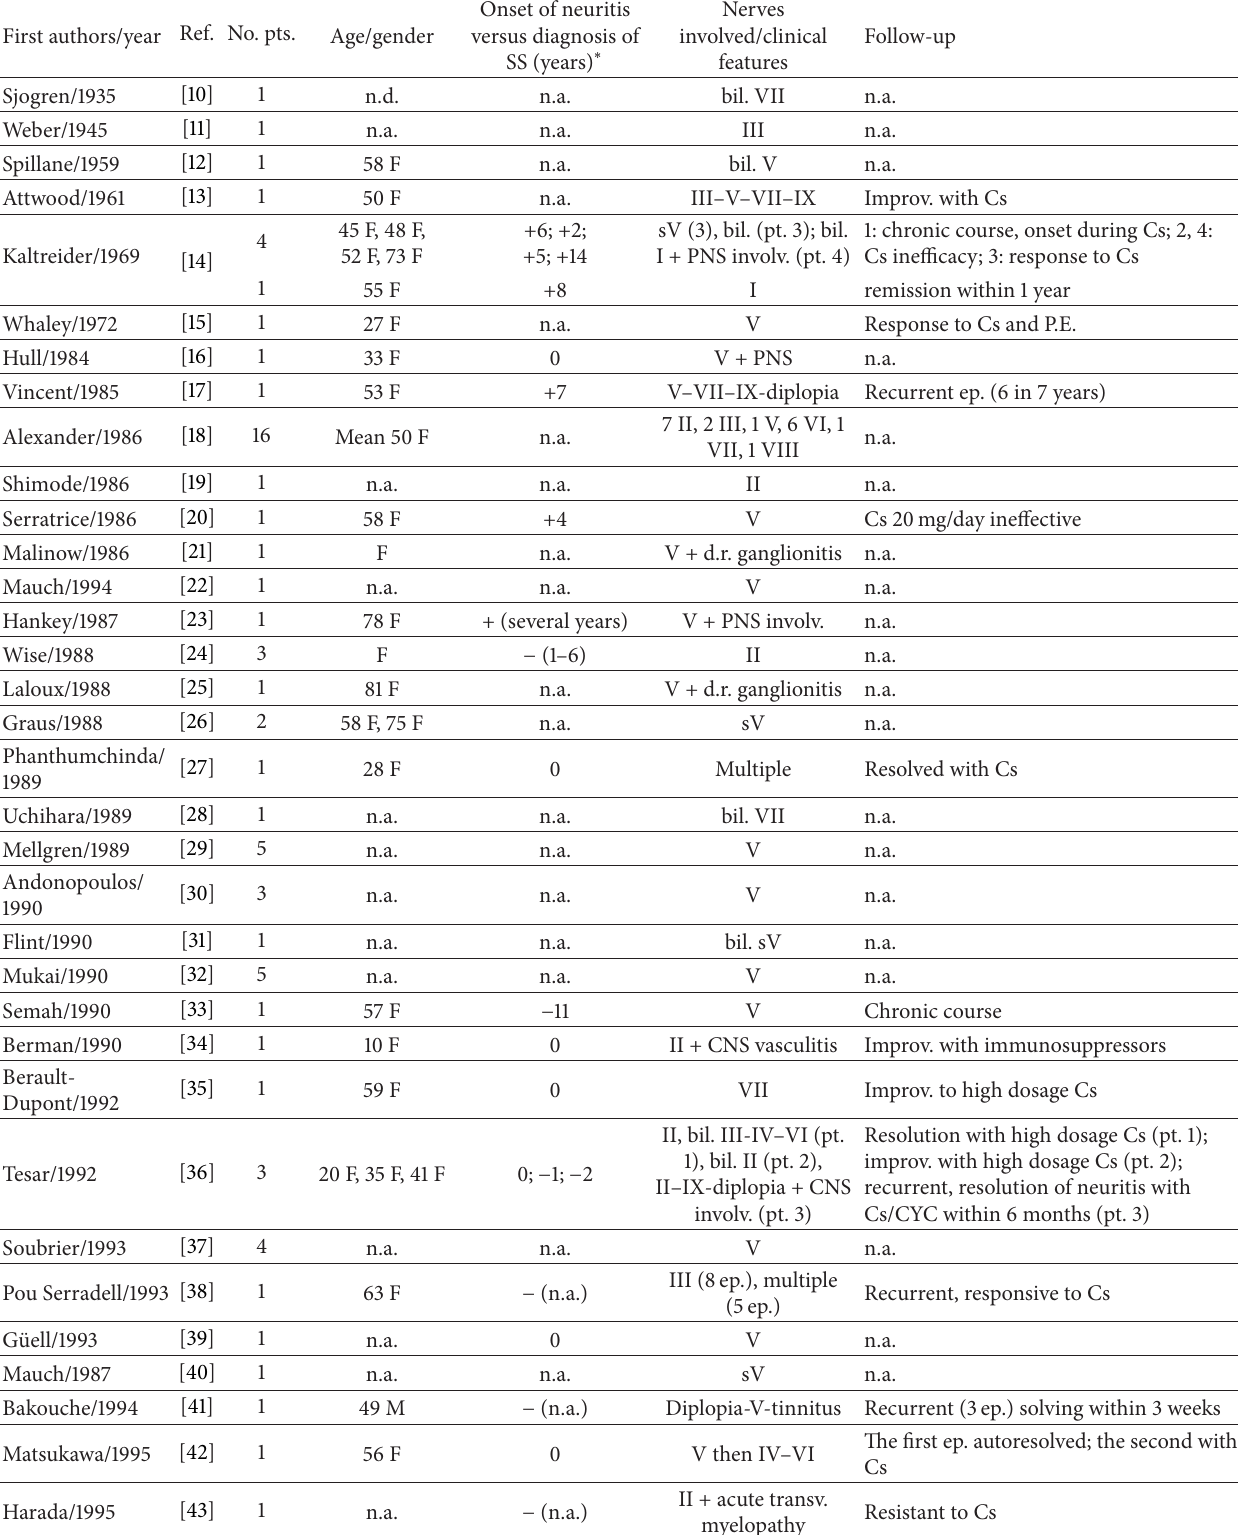
Table 1: Review of the literature regarding Sj¨ogren’s syndrome (SS) patients with cranial neuritis. First authors/year Ref. No.